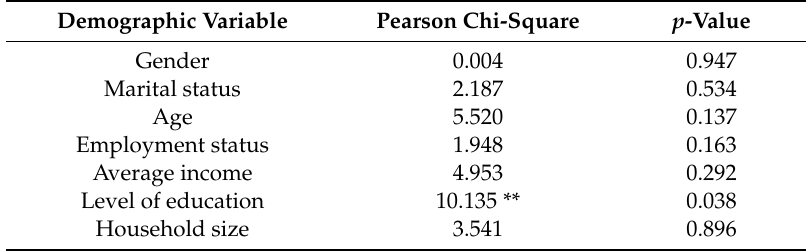
Table 4. The relationship between demographic variables and the utilisation of organic waste through urban agriculture in the Durban South Basin (n =